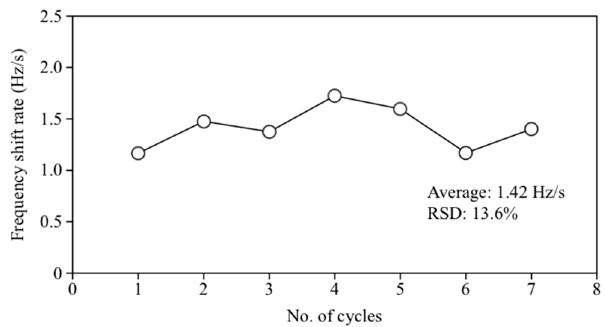
Figure 6. Reproducibility of frequency-shift rates from the same QCM sensor ( n = 7).